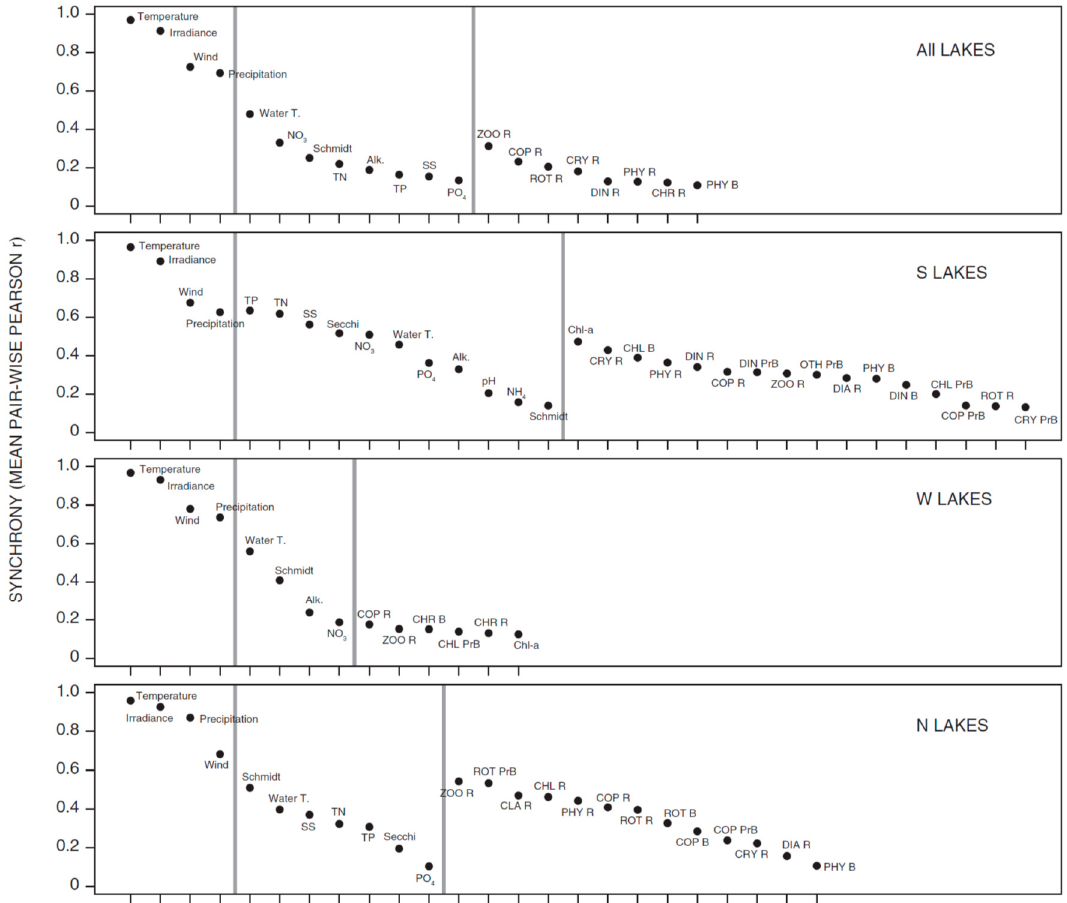
Figure 3. Summary of the synchrony in climate, lake physico ‐ chemistry and plankton variables for the whole year excluding winter analysed for all lakes and for the S, W and N lakes separately. Y axis represents synchrony calculated as mean pairwise correlation of each variable. Only variables with r > 0.1 are given and main variable groups are divided by vertical lines as climate, lake water characteristics and plankton variables. Results of separate analyses for each season are given in the Figures A2–A4.